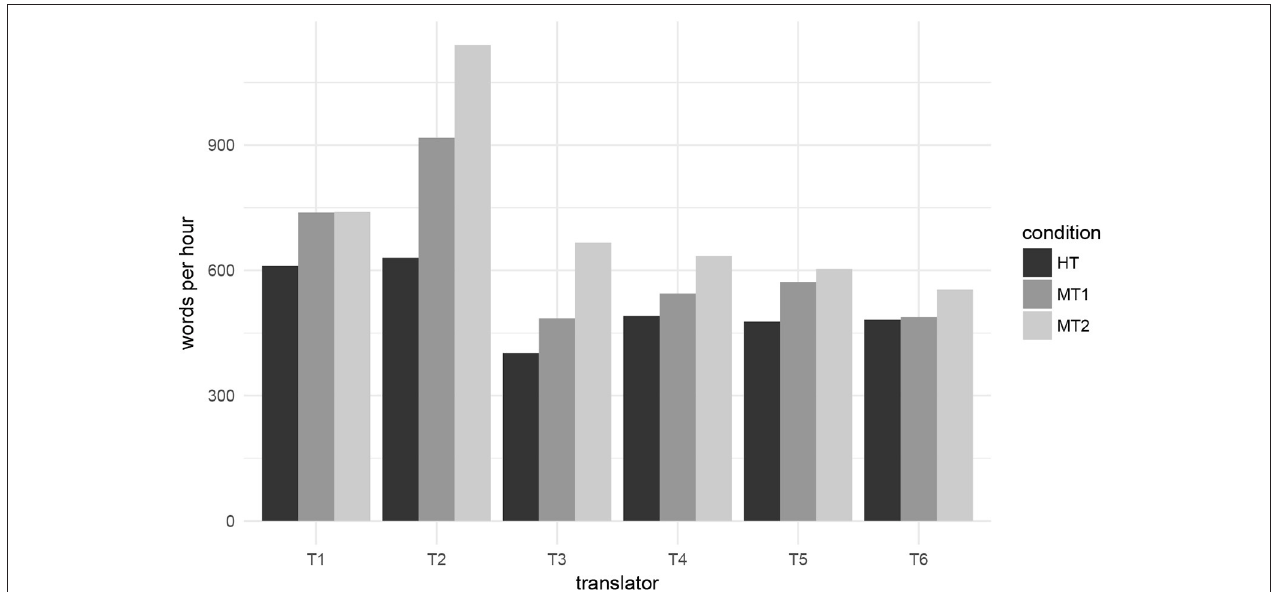
FIGURE 2 | Translation productivity measured as words per hour for each of the translators in each of the translation